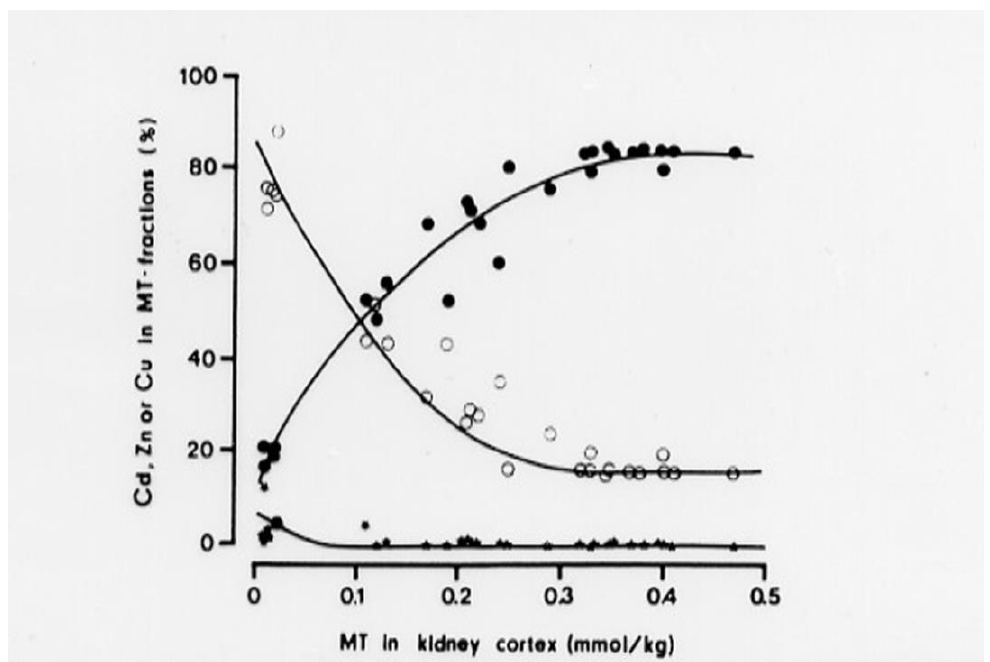
Figure 3. The relative concentrations (percent ) of Cd (filled circles), Zn (open circles) and copper (black dots) in MT fractions in relation to the total MT concentration. MT isolated from the kidneys of rabbits with varying exposure to Cd [61].